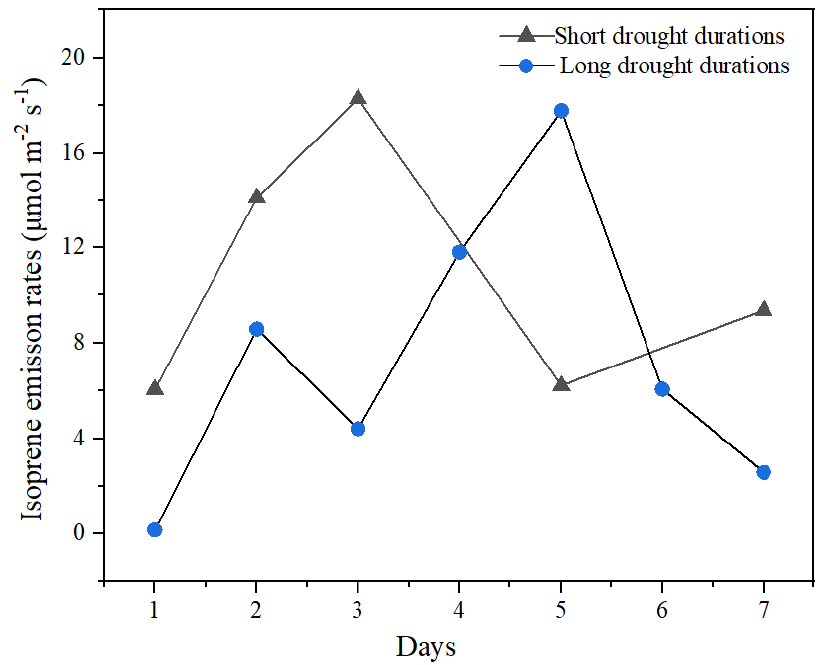
Figure 3. The isoprene emission rates during rehydration after short and long drought durations.